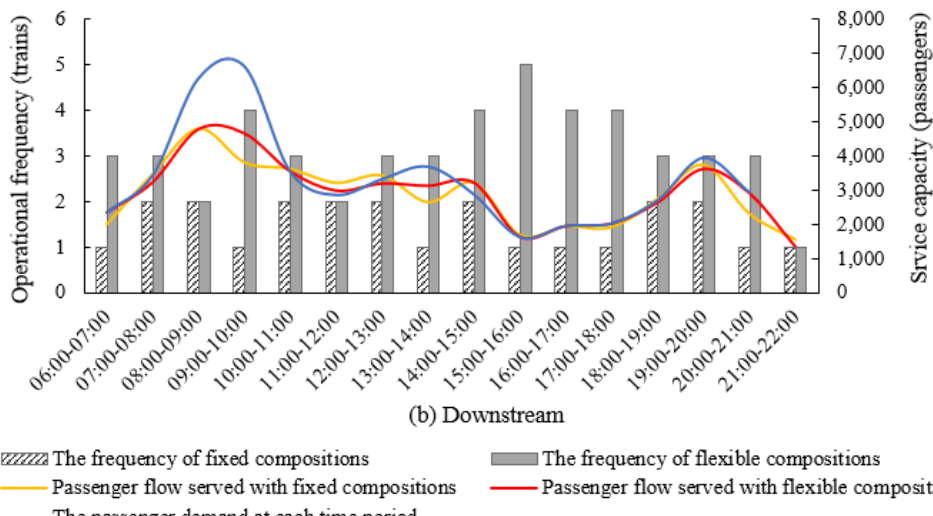
Figure 9. The operational frequency and service capacity analysis in the upstream and downstream direction when N = 60.